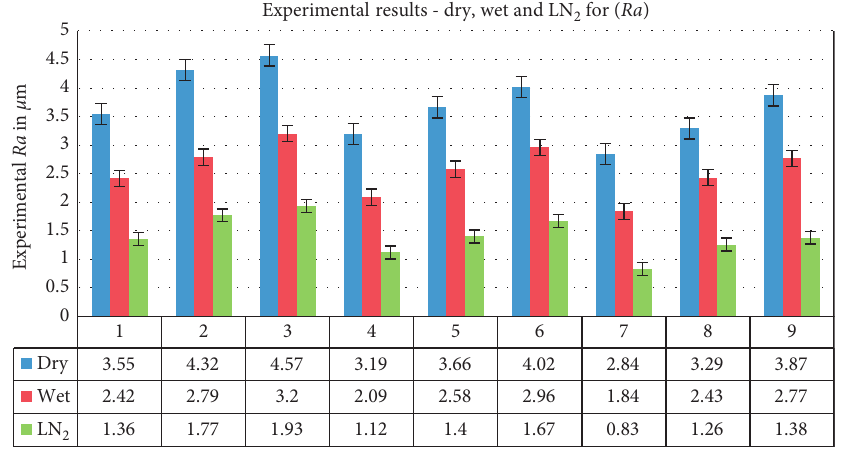
Figure 4: Experimental results using OFA: dry, wet, and LN